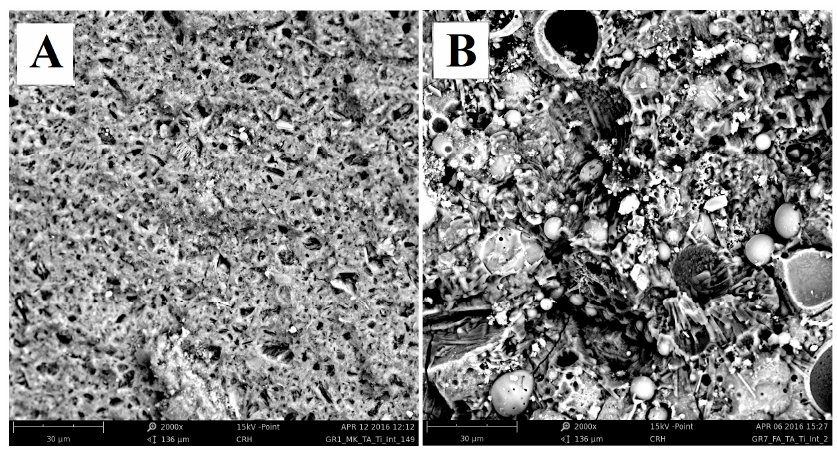
9 of 13 Figure 5. SEM images of surface at 8000 magnifications of the samples: ( A ) metakaolin-based geopolymer; ( B ) metakaolin (MK); ( C ) fly ash-based geopolymer; and ( D ) FA. SEM images of sections of the MK and FA samples have been also carried out (Figure 6). While